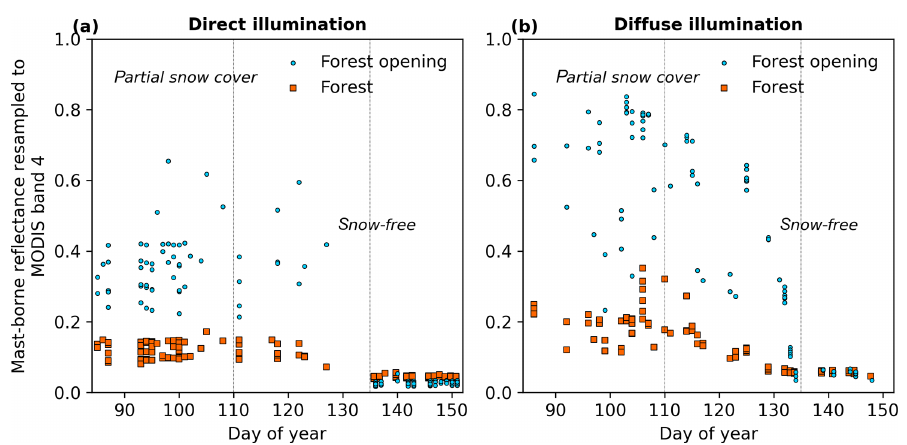
Figure 10. Mast-spectroradiometer observations from both forest and forest opening during the spring of 2013 resampled to correspond to MODIS band 4 (545–565nm) reflectance in (a) direct (cloudiness 0–2 / 8) and in (b) diffuse (cloudiness 7–8 / 8) illumination conditions.